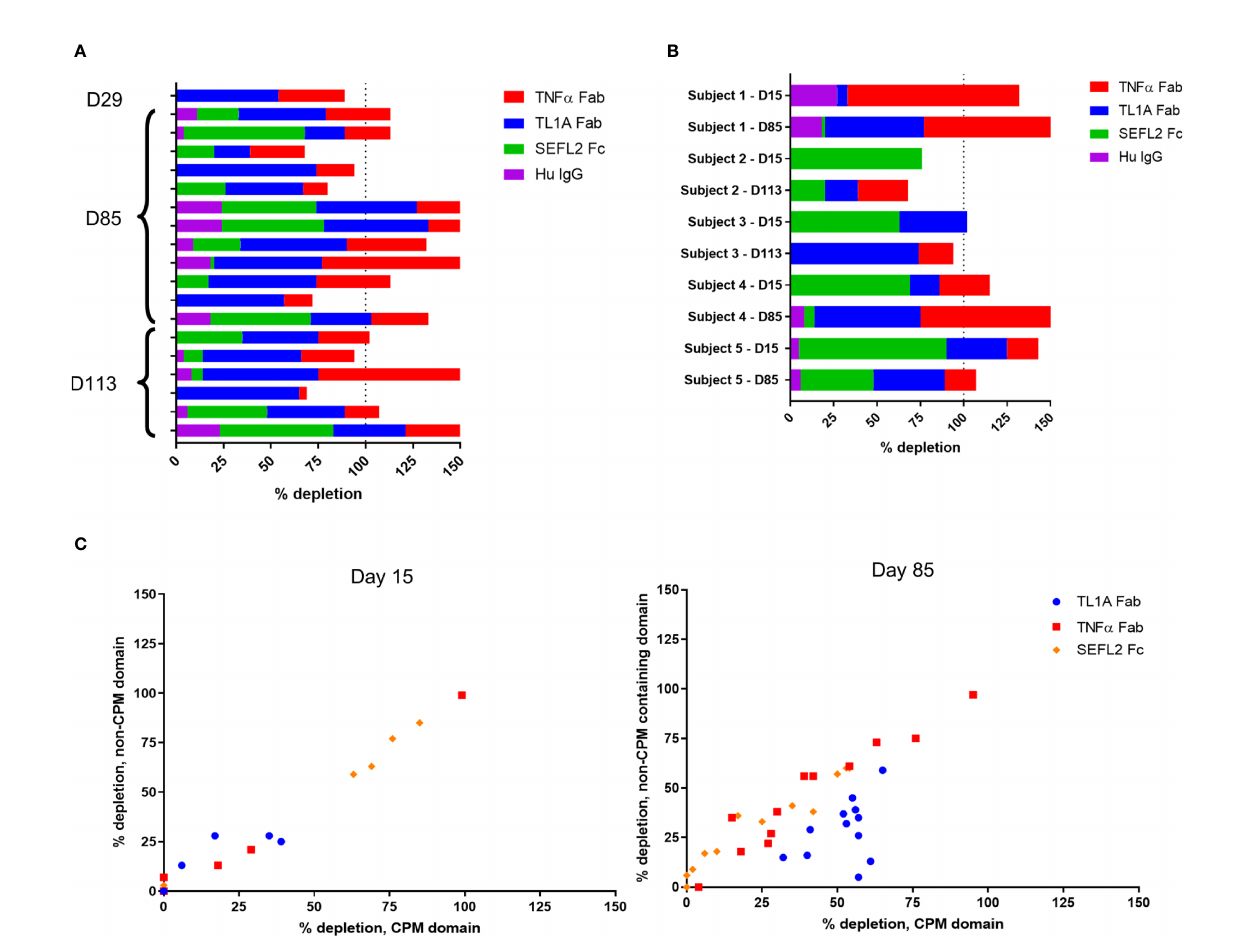
FIGURE 4 | Anti-AMG966 antibodiesboundtoalldomains ofAMG966andbecamespeci fi cfor TL1Achargepair mutations over time. Domaincharacterizationwas performedbypre-treating serum sampleswithvariousdomainsofAMG966 andthenre-testingintheADAassaytodeterminetheextenttowhichassaysignalwasdepleted. Percentdepletionwascalculatedbydividing thedifferencebetweentreatedanduntreatedsamplesbytheuntreatedsignal. (A) Antibodypositive samplesfrom 19 subjects from cohorts1-4 wereassessedfor bindingtoeachdomainofAMG966 or bulkhumanIgGnegativecontrol.Thetimepointforeachsample isindicatedonthey-axis. (B) Paired antibodypositive samplesfrom thesamesubjectwere analyzedatday15andday85/113toexplorehow thespeci fi cityoftheantibodyresponsechanges overtime.Data shownrepresent2pairedsamplesfrom cohort1,2pairs fromcohort2, and1pair from cohort3. (C) Antibodypositivesampleswerepre-treatedwitheither